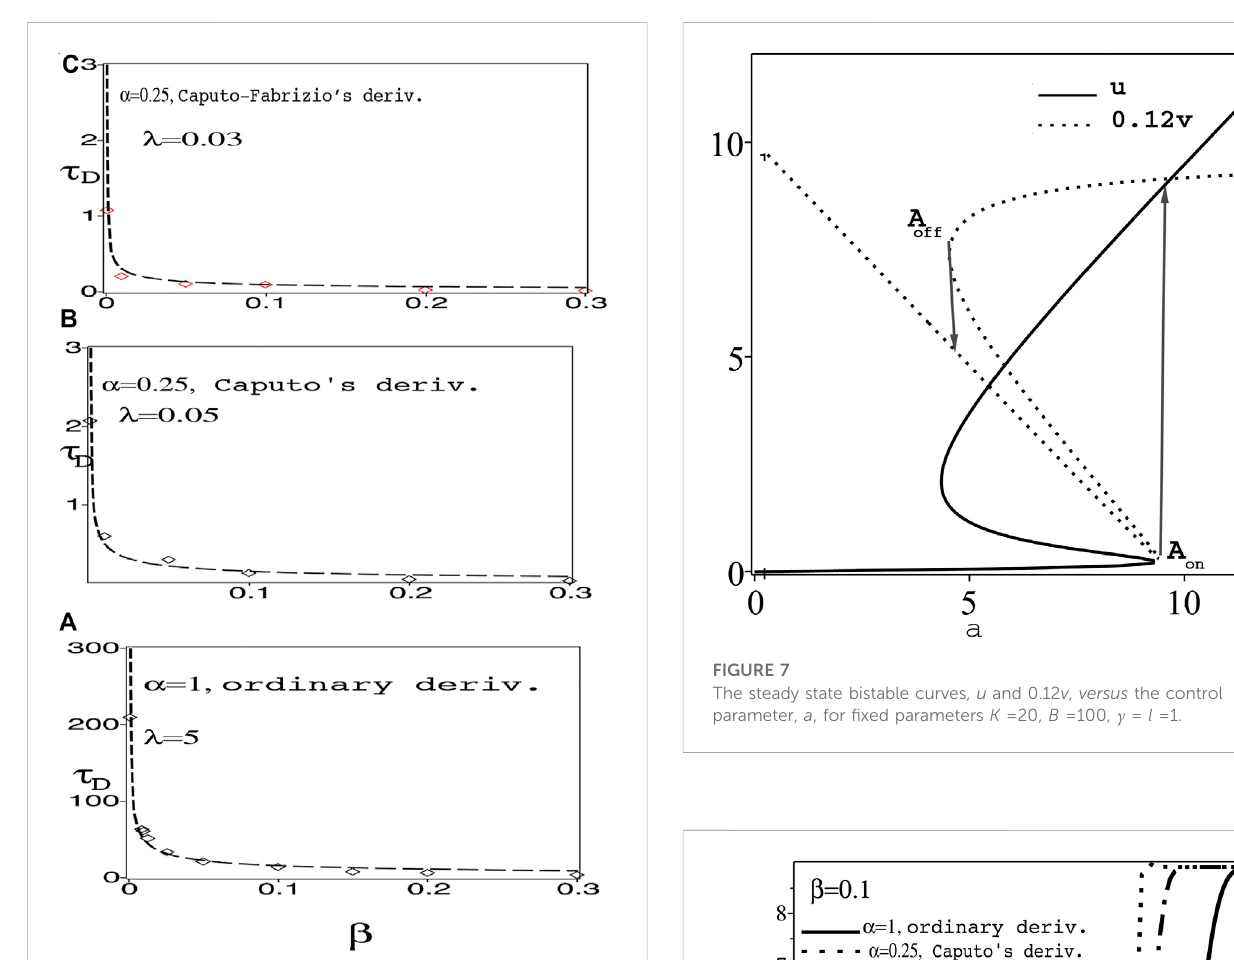
(cid:1)(cid:1) (cid:3) β .